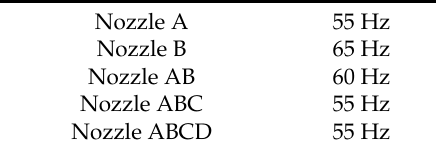
Figure 2. Frequency characteristics of SJA measured at 1.0 W. The local maxima indicate the resonance frequencies for all particular nozzle cases; they are also summarized in Table 2. Table 2. Identified resonance frequencies for particular nozzle cases.